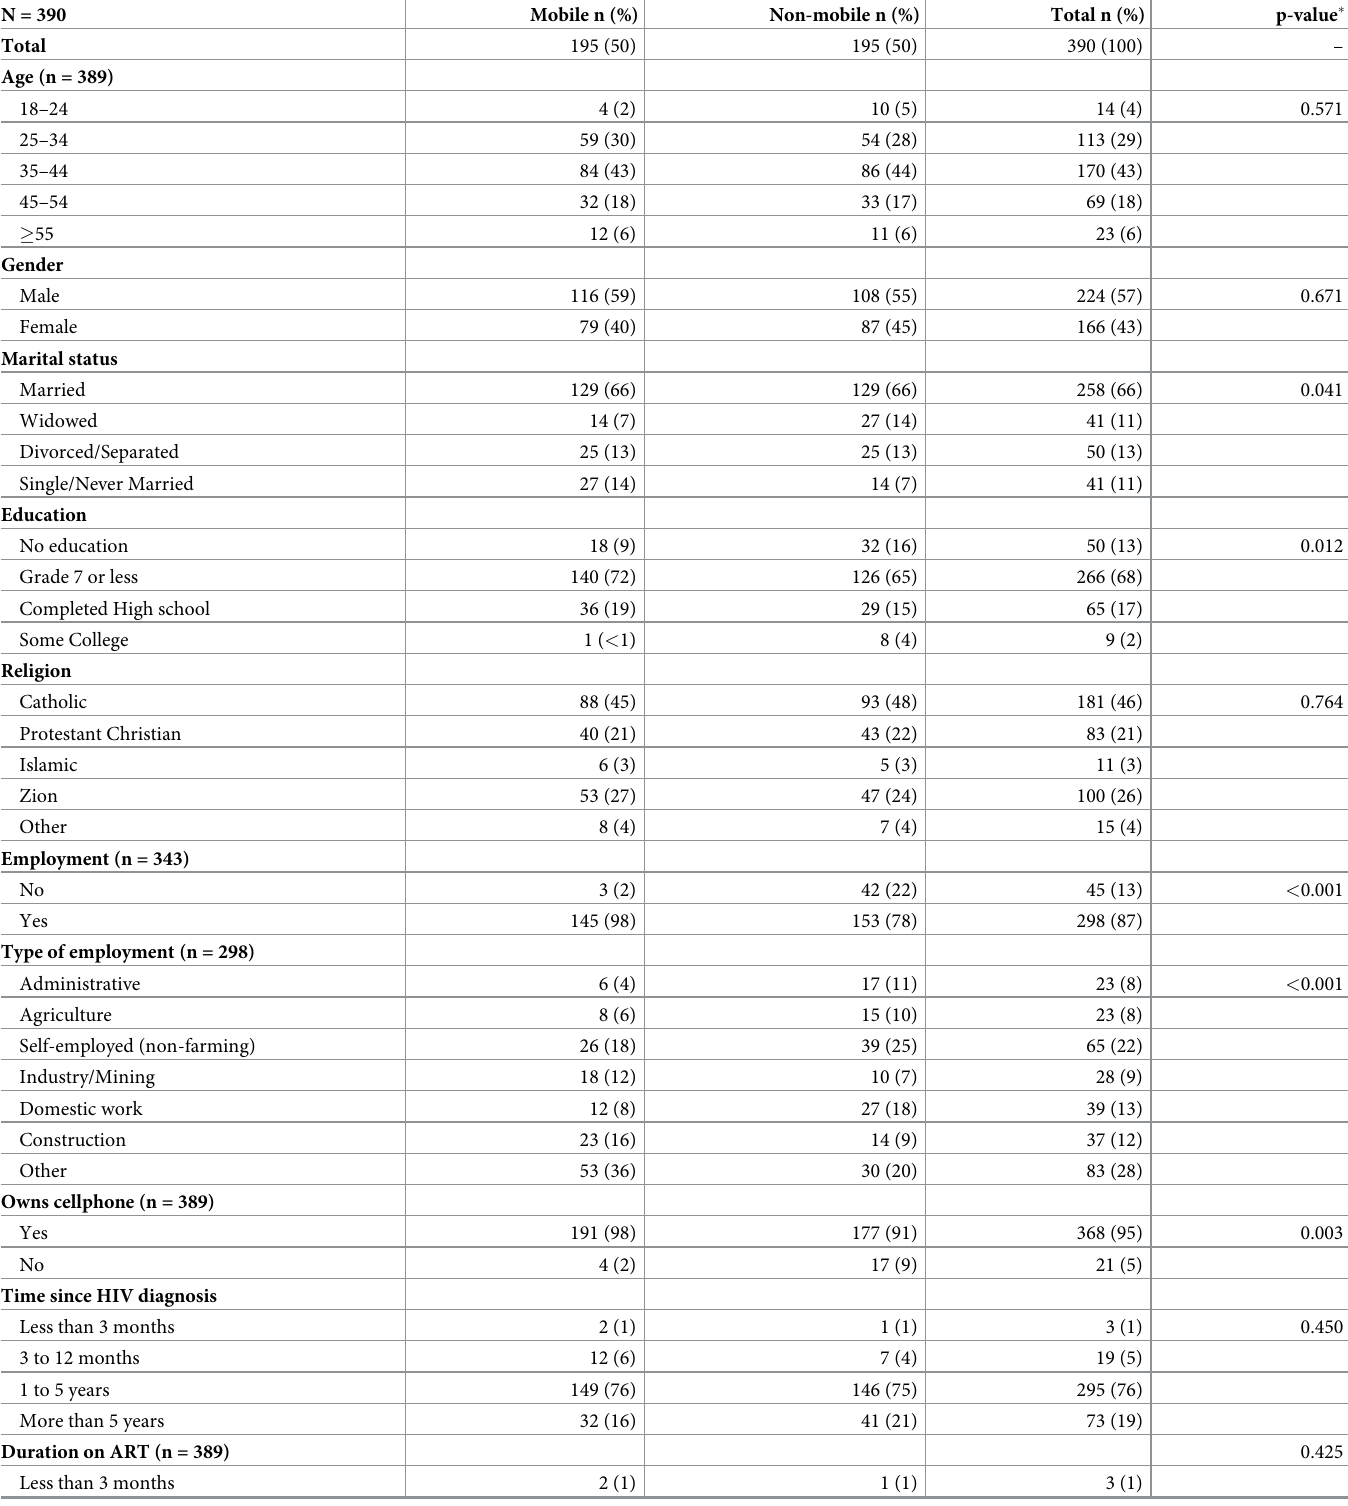
Table 1. Sociodemographic characteristics of mobile and non-mobile HIV-positive adults enrolled in HIV care and treatment at Manhic¸a District Hospital. N =